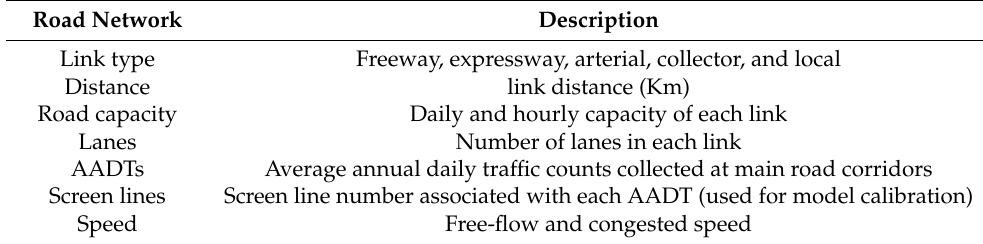
Table 1. Road network